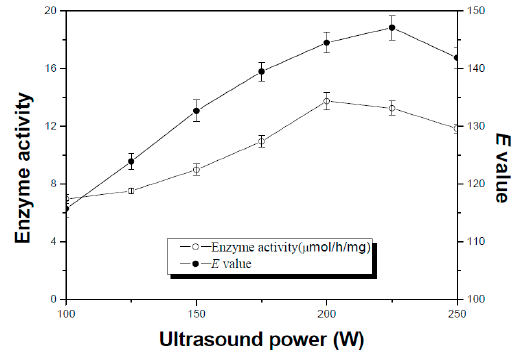
Figure 3. Effect of ultrasound power on the enzymatic esterification of ibuprofen. Reaction conditions: the reactions were carried out in n -heptane (10 mL, a w 0.21) with racemic ibuprofen (0.2 mmol), 1-octanol (0.2 mmol) and the immobilized APE1547 powder (160 mg) at 45 °C.